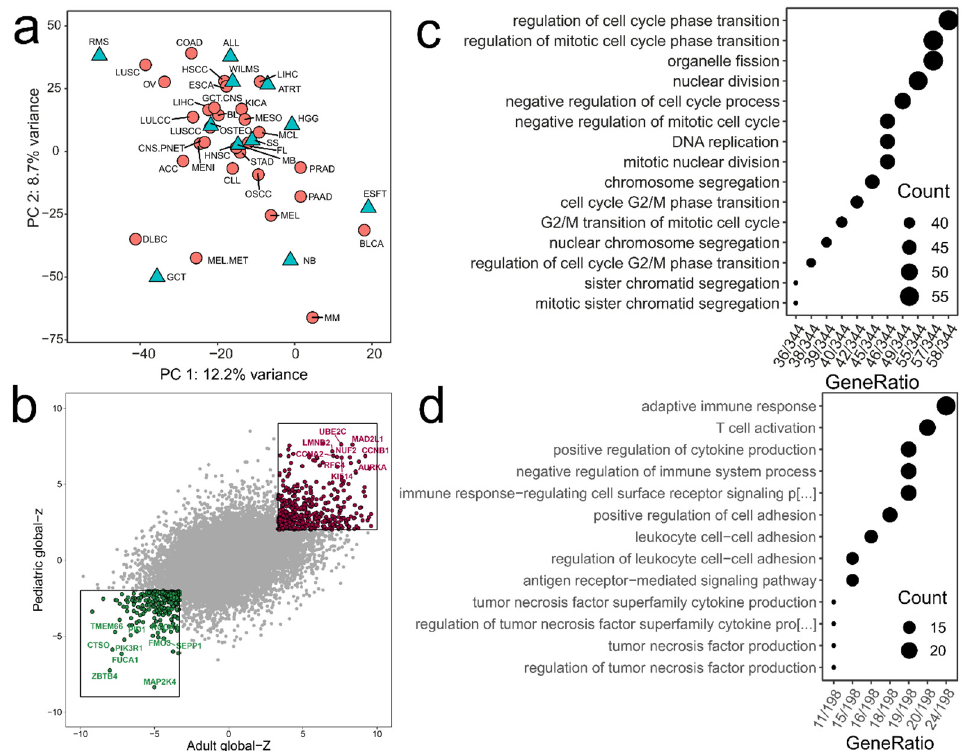
Figure 1. Prediction of clinical outcomes from genomic profiles (PRECOG) in adult versus pediatric tumors ( a ) Principal component analysis (PCA). Comparison of the prognostic landscape (meta-z-scores) of 34 adult tumors (red circles) [27] and 12 tumors occurring in children and young adults (“pediatric tumors“, cyan triangles) (“PRECOG-cohort”, n = 3094). Tumors with similar histogenesis, such as neuroblastoma, melanoma and melanoma metastases cluster closely together, indicating a trend for similar gene prognostic associations. ( b ) Dot plot comparing global meta-z-scores (PRECOG) of pediatric ( n = 12) versus adult malignancies ( n = 34) [27]. The correlation was significant (Pearson r = 0.39; p < 2.2 × 10 − 16 ). Top favorable prognostic genes in green, top adverse prognostic genes in red. Full list pediatric global meta-z-score and individual meta-z-scores for each gene: Table S3. ( c , d ) Gene ontology (GO) enrichment of pediatric adverse (c) and favorable ( d ) prognostic genes. The dot plot of pediatric vs. adult global z-values ( b ) was subdivided into sectors, upper right sector (red): genes adverse prognostic in pediatric and adult tumors, lower left sector (green): favorable prognostic genes in pediatric and adult tumors. GO enrichment was performed on the genes of the respective sector using the GO biological processes database. Dot plots show significantly enriched terms, defined by a Bonferroni corrected p -value < 0.05 and a FDR < 0.05. Abbreviations: Pediatric tumors: atypical teratoid rhabdoid tumor, ATRT; Ewing’s sarcoma family of tumors, ESFT; germ cell tumors, GCT; high grade gliomas, HGG; medulloblastomas, MB; neuroblastoma, NB; osteosarcoma, OSTEO; CNS-PNETs; rhabdomyosarcoma, RMS; synovial sarcomas, SS; Wilms tumors, WILMS. Adult tumors: adrenocortical cancer, ACC; bladder cancer, BLCA; astrocytoma, ASTR; glioblastoma, GBM; glioma, LGG; meningioma, MENI; breast cancer, BRCA; colon cancer, COAD; gastric cancer, STAD; head and neck cancer, HNSC; hypopharyngeal cancer, HSCC; esophageal cancer, ESCA; oral SCC, OSCC; AML, LAML; Burkitt lymphoma, BL; CLL, CLL; DLBCL, DLBC; follicular lymphoma, FL; mantle cell lymphoma, MCL; multiple myeloma, MM; kidney cancer, KICA; liver cancer, LIHC; lung adenocarcinoma, LUAD; large cell lung cancer, LULCC; squamous cell lung cancer, LUSCC; small cell lung cancer, LUSC; melanoma, MEL; melanoma metastasis, MEL MET; mesothelioma, MESO; ovarian cancer, OV; pancreatic cancer, PAAD; prostate cancer, PRAD.